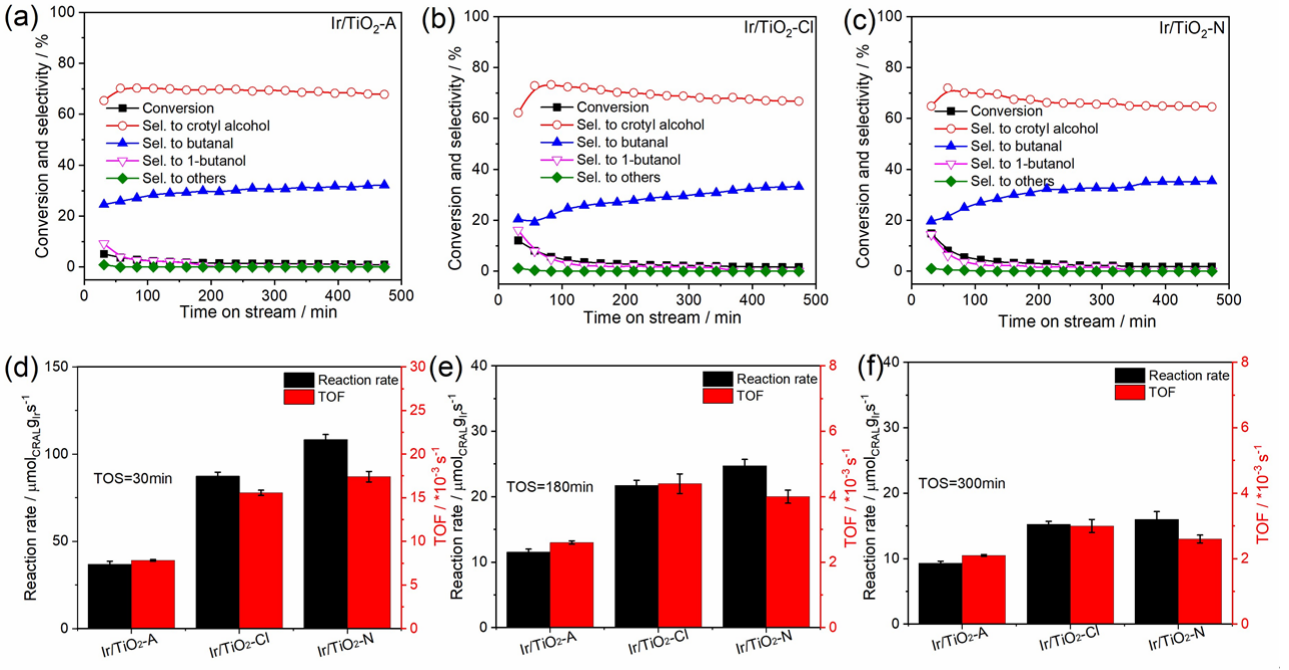
Figure 6. ( a – c ) Time course of selective hydrogenation of vapor phase CRAL over the pre-reduced Ir/TiO 2 catalysts and ( d – f ) comparison of their CRAL reaction rates and CROL formation TOF at time on stream (TOS) of 30, 180 and 300 min. (Reaction condition: catalyst loading: 5 mg diluted with 195 mg silica, reaction temperature = 80 °C; total flow rate = 26 mL min-1; CRAL content = 1 mol.%).